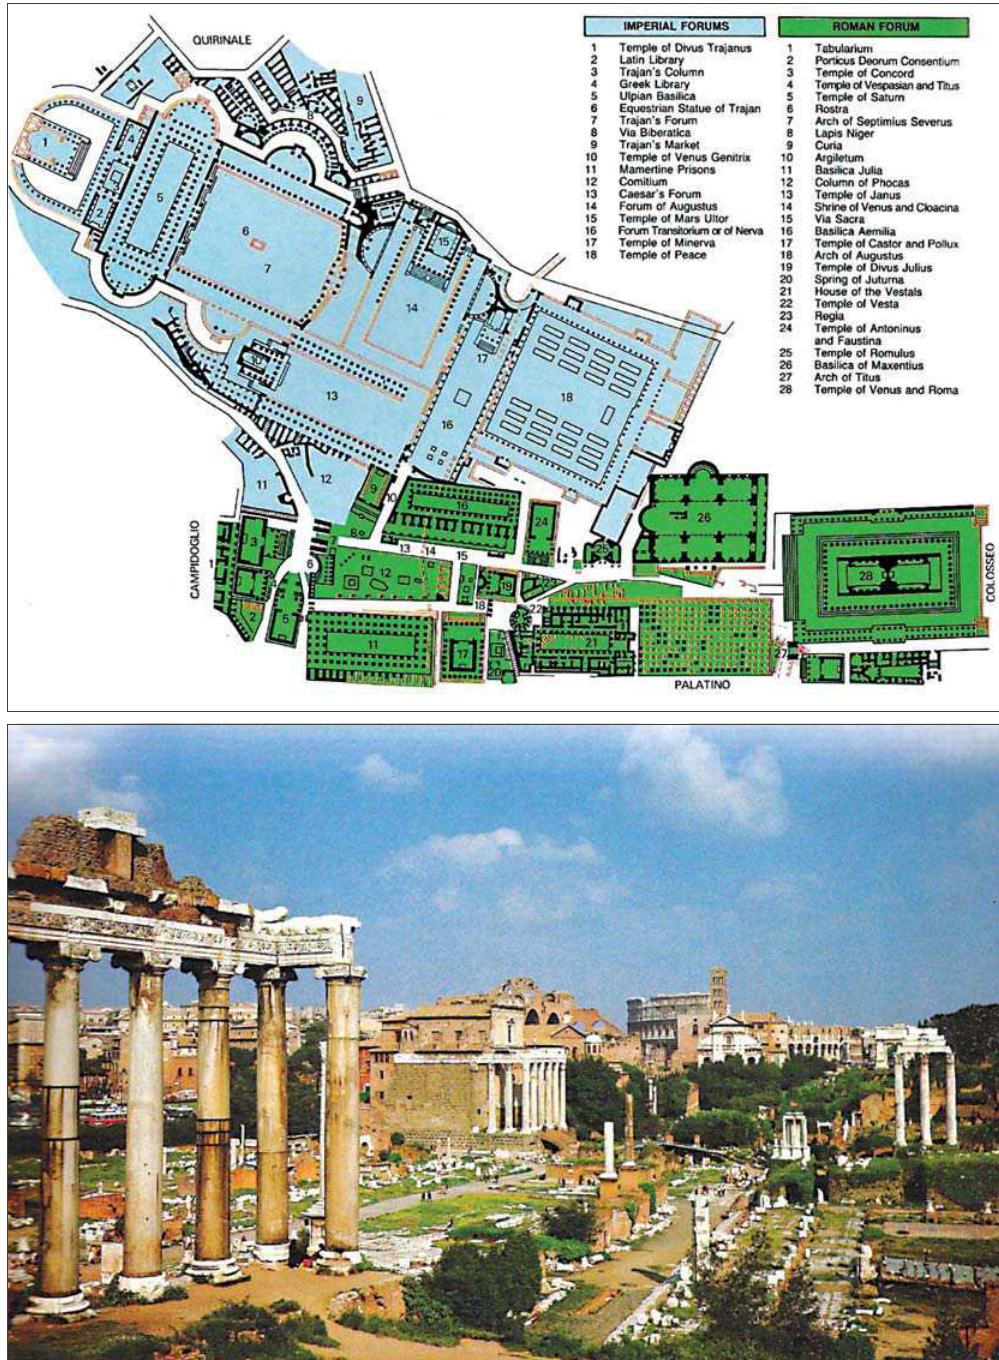
Fig 1. Plan of Imperial and Roman forums in Rome and fragments of remained stately